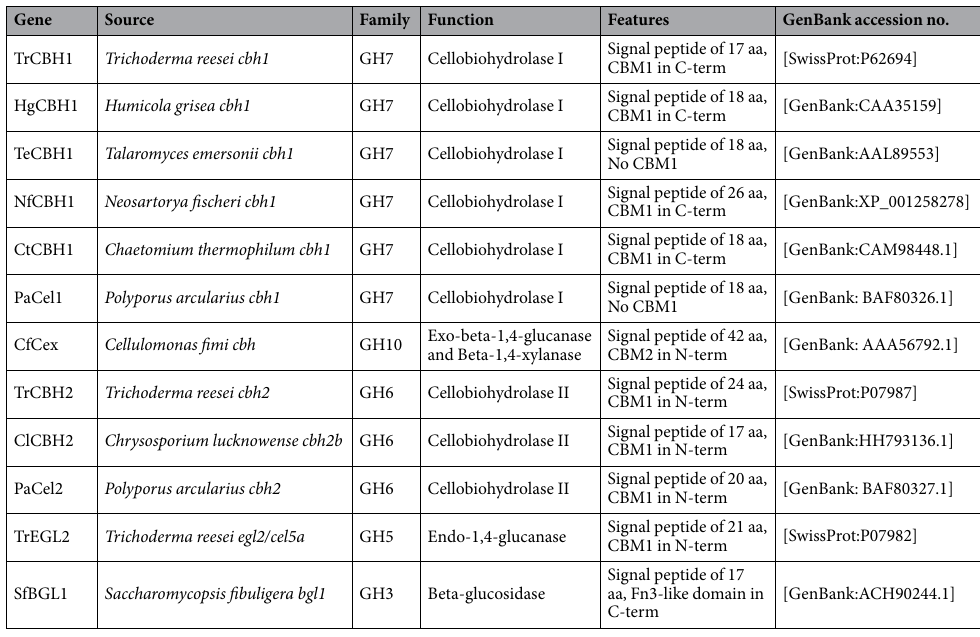
Table 1. Genes encoding the cellulases used in this